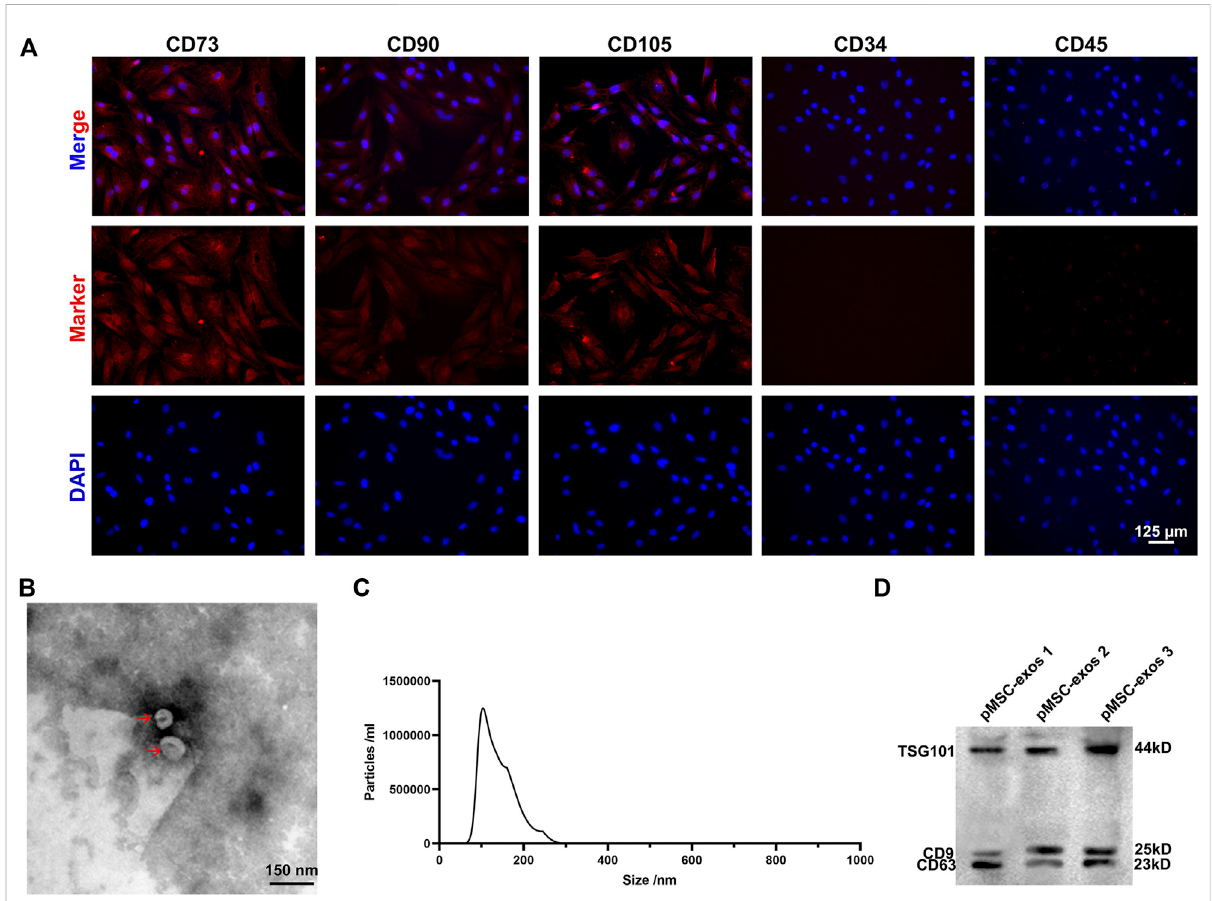
FIGURE 1 CharacterizationofpMSCsandpMSC-exos. (A) ThecellsisolatedfromtheplacentawereexpressedpositivelyforCD73,CD90,andCD105,and negativelyforCD34andCD45viaIFstaining. (B) MorphologyofpMSC-exosviatransmissionelectronmicroscopy. (C) ParticlesizeofpMSC-exosvia NanoSight. (D) Detectionofexosome markers (TSG101, CD9and CD63)inpMSC-exos viawesternblotassay. MSC,mesenchymalstemcell; pMSCs, placental MSCs; pMSC-exos, pMSC-derived exosomes; IF, immuno fl